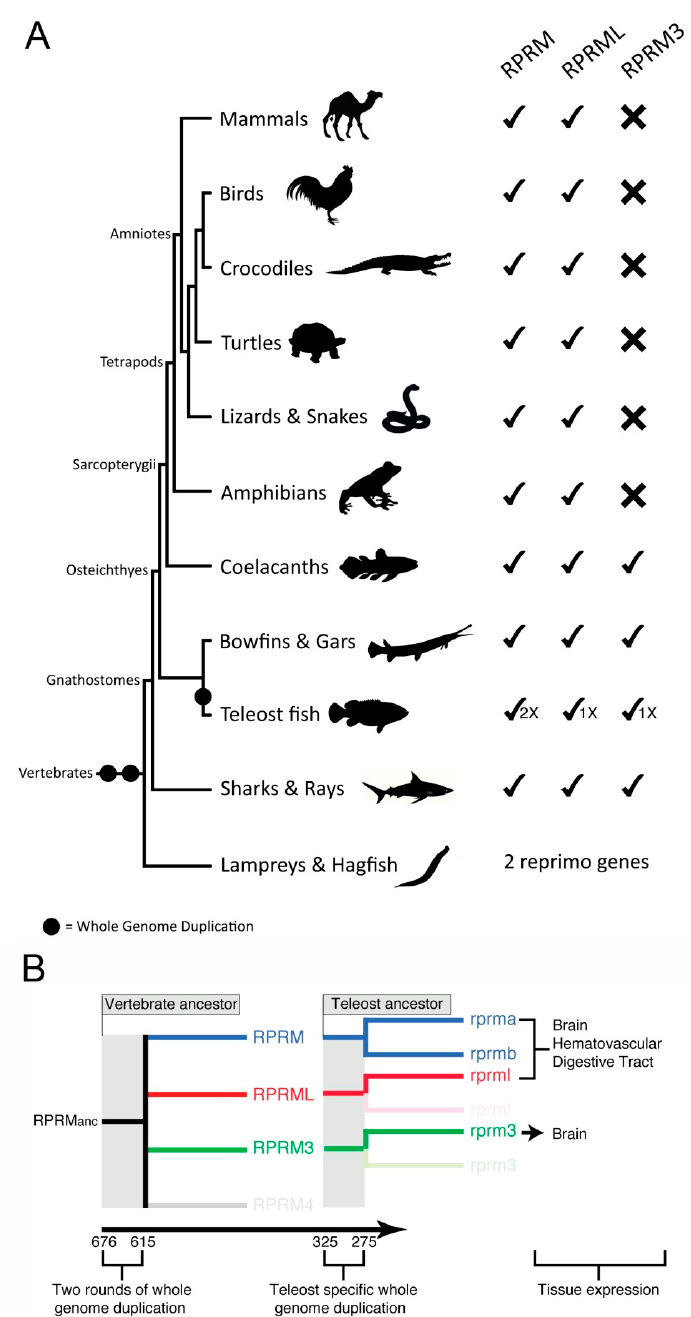
Figure 2. Evolution and diversification of RPRM genes in vertebrates. ( A ) During the diversification of vertebrates RPRM genes were differentially retained, as not all RPRM genes are present in all main groups of vertebrates. Thus, RPRM and RPRML genes were retained in all main groups of jawed vertebrates (gnathostomes), whereas RPRM3 was only retained in four distantly related groups: cartilaginous fish (e.g., sharks, skates, and rays), holostean fish (e.g., bowfish and gars), teleost fish (e.g., zebrafish) and coelacanths. In the group that includes lampreys and hagfish, two RPRM genes have been identified, however, phylogenetic and synteny analyses have failed in defining orthology. ( B ) Schematic representation of the evolution of the RPRM gene family in teleost fish. On the left, the RPRM gene family diversified as a product of the two rounds of whole-genome duplication occurred in the vertebrate ancestor, as well as, a teleost-specific whole genome duplication. On the left, the expression territories of the three RPRM gene lineages present in teleost fish.